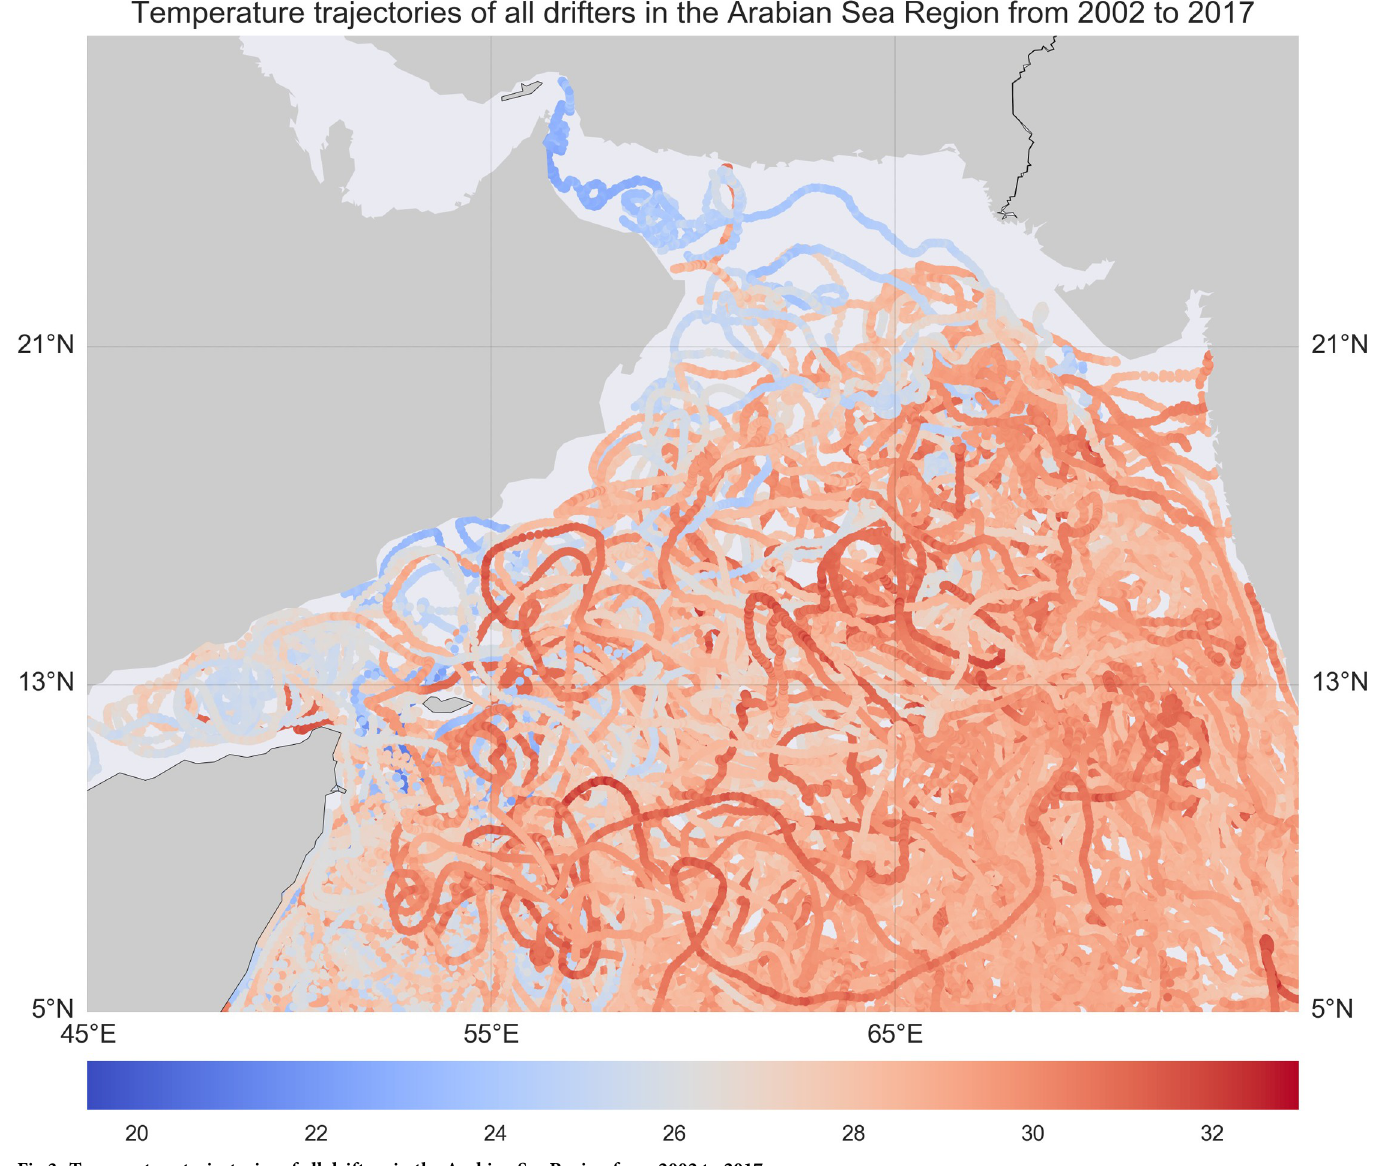
Fig 3. Temperature trajectories of all drifters in the Arabian Sea Region from 2002 to 2017.